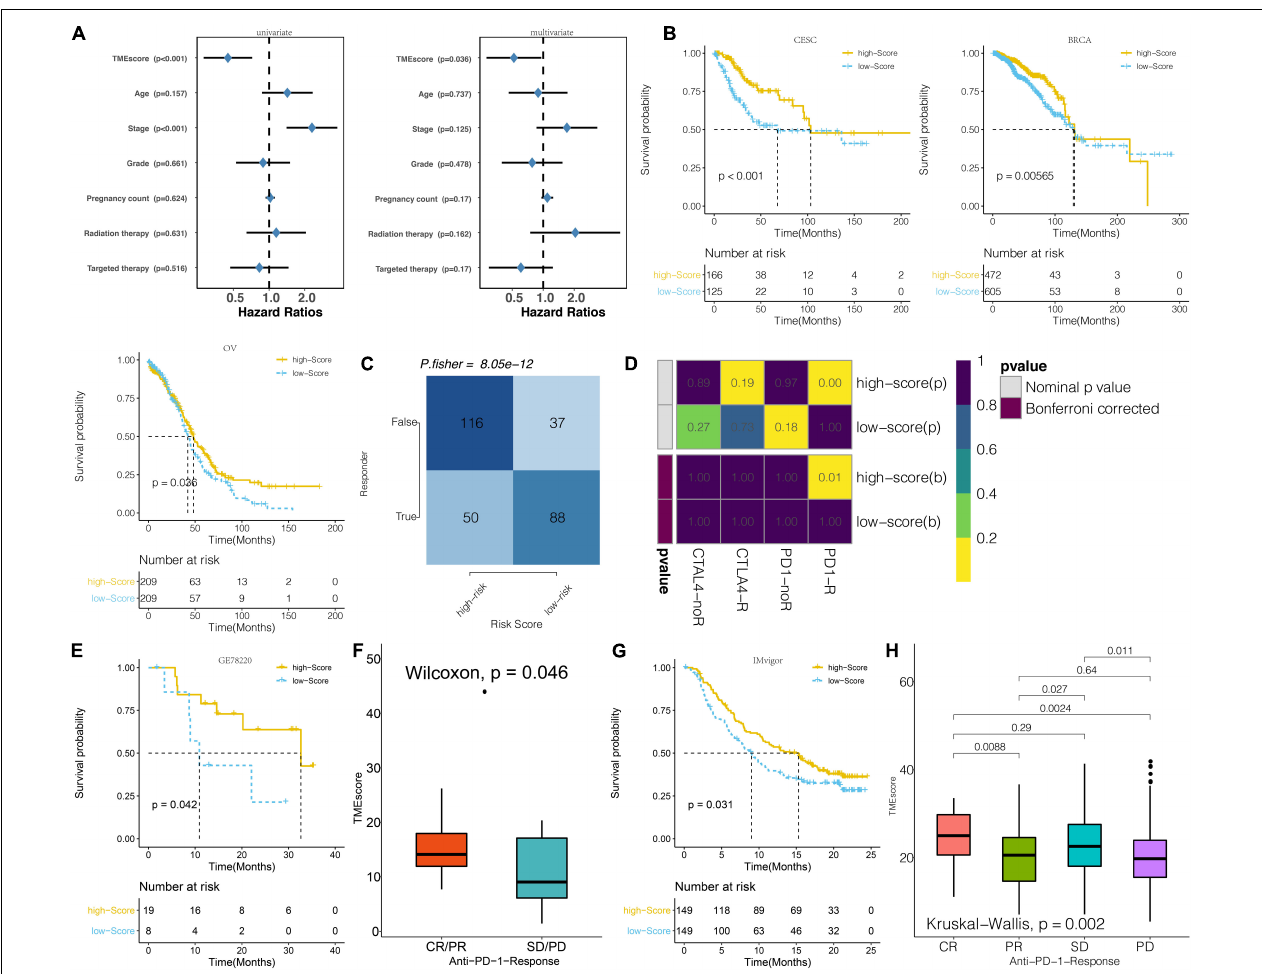
FIGURE 7 | Prognosis potential of TME score for immunotherapeutic response. (A) Univariate and multivariate Cox regression model estimating prognostic potential of TME score, patient age, tumor stage, tumor grade, pregnancy count, radiation therapy, and targeted therapy in TCGA. (The length of horizontal line represents the 95% confidence interval for each group. The vertical dotted line represents the HR of all patients. HR < 1.0 indicates that a high TME score is a biomarker for positive prognosis). (B) Kaplan–Meier curves for the two groups of patients classified along the TME score for CESC, BRCA, and OV from the TCGA. (Log-rank test showed an overall P < 0.001). (C) The TIDE value and response to immunotherapy for the TME score clusters. (D) Submap analysis based on the TIDE algorithm for differential response to CTAL-4 and anti-PD-1 therapy with regard to the TME score for the TCGA dataset. (E) Kaplan–Meier curves for the two groups of melanoma patients classified based on TME score for GSE78220. (Log-rank test showed an overall P < 0.001). (F) TME scores for groups with different anti–PD-1 clinical response status (CR/PR and SD/PD) in the GSE78220 dataset. (Wilcoxon, P = 0.019). (G) Kaplan–Meier curves for the two groups of patients classified based on the TME score in the IMvigor cohort. (Log-rank test: P < 0.001). (H) Distribution of TME scores in groups with different anti–PD-L1 clinical response statuses in the IMvigor